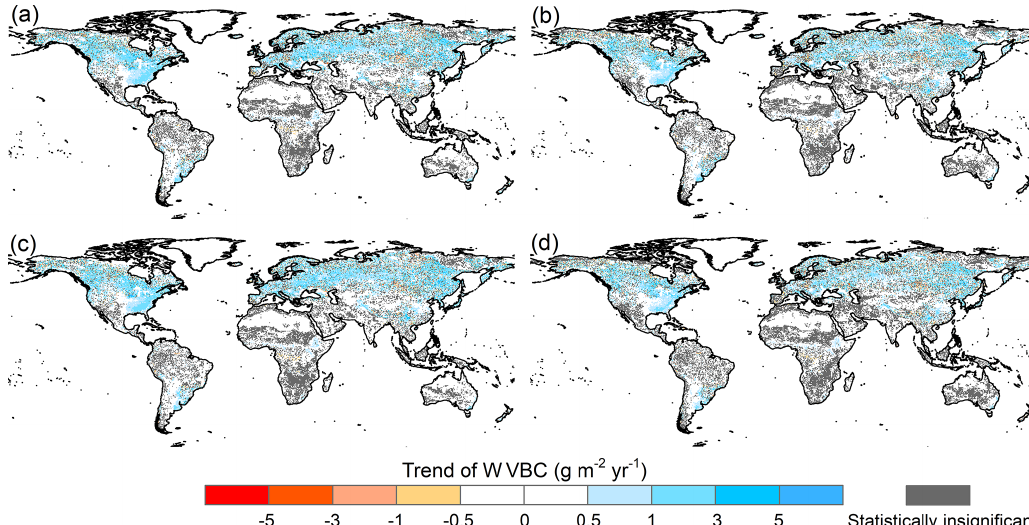
Figure A3. Potential WVBC variation trend maps during the period of 1916 to 2015 under different factorial simulations. (a) CO 2 driving factorial simulation (S2), (b) CO 2 + precipitation driving factorial simulation (S3), (c) CO 2 + temperature driving factorial simulation (S4), and (d) CO 2 + radiation driving factorial simulation (S5). Positive values indicate increasing trends in the ratio, and vice versa. All results from the Mann–Kendall and Sen slope statistical tests correspond to the 95% confidence